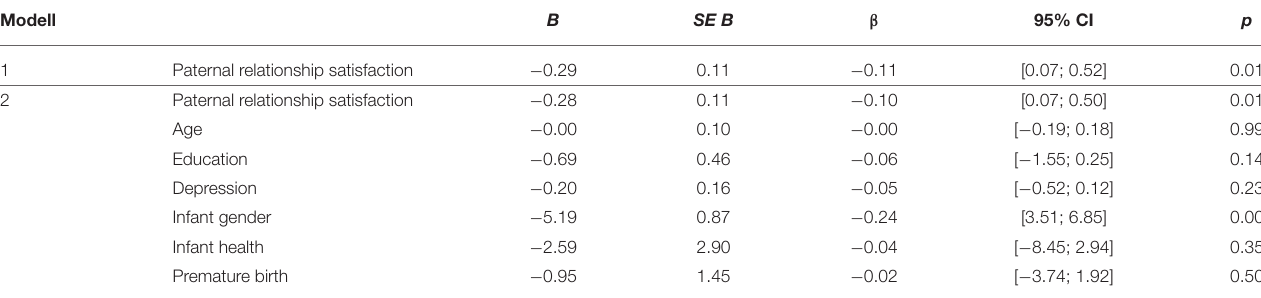
TABLE 4 | Predictive value of paternal relationship satisfaction on infant personal-social development, controlled for parental age, education, depression, infant gender, infant health, and premature birth a .